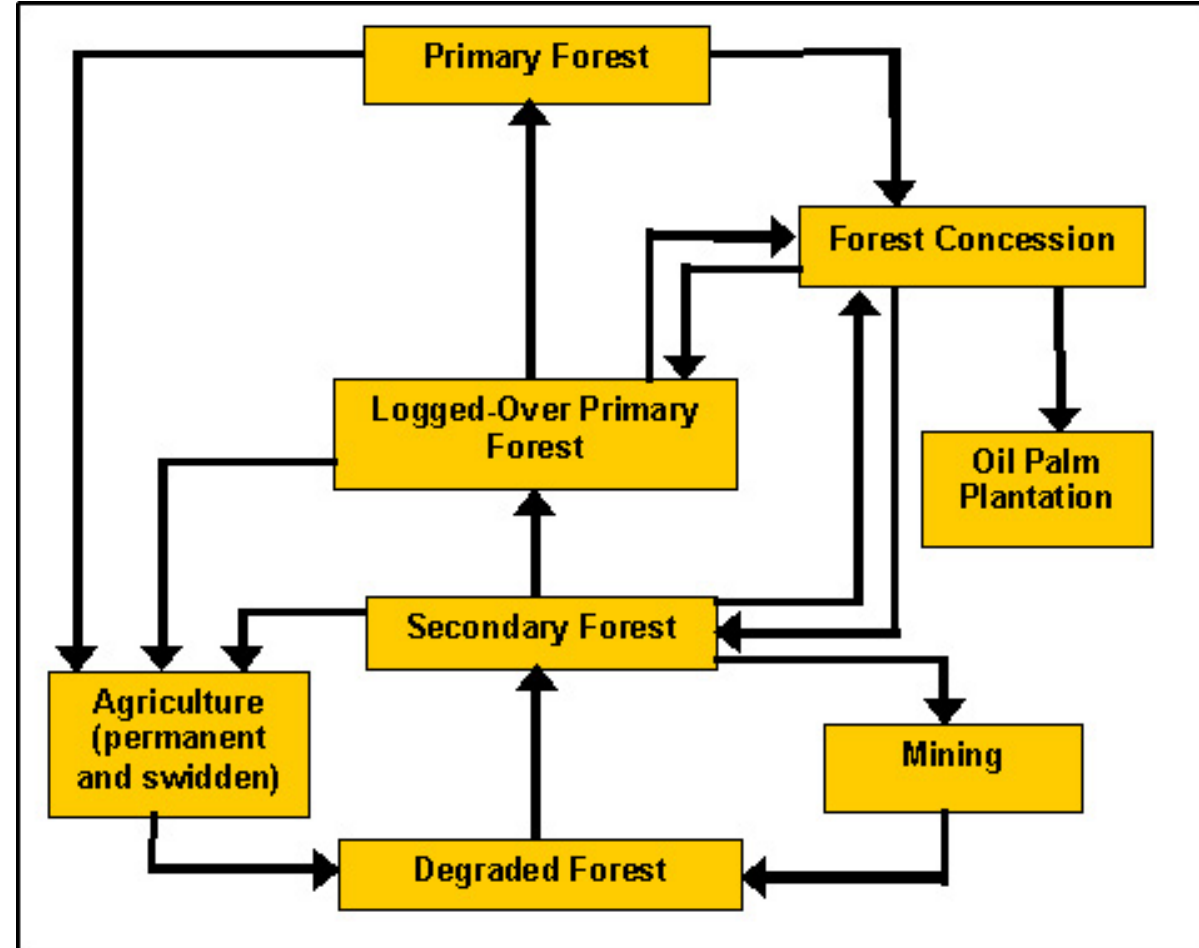
Fig. 2. Major land-use sectors captured in the model, showing the potential land-use